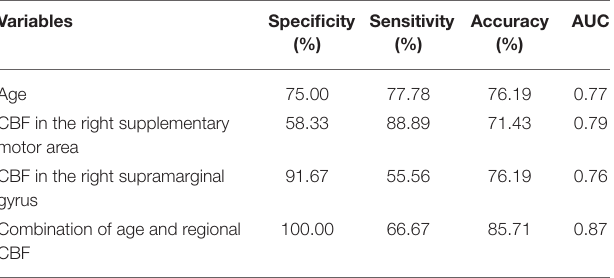
TABLE 3 | ROC analysis for identifying AD patients with depression from AD patients without depression using age and regional CBF.